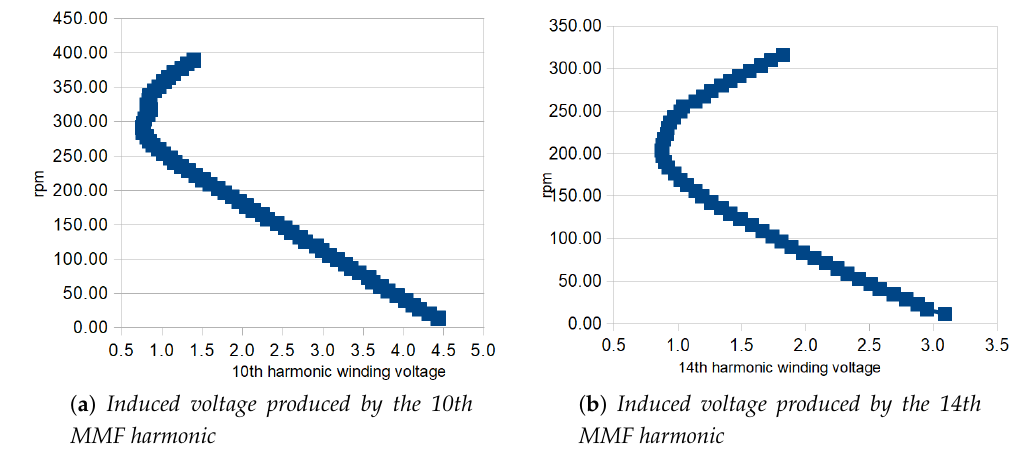
Figure 17. EMF trends vs. rotation